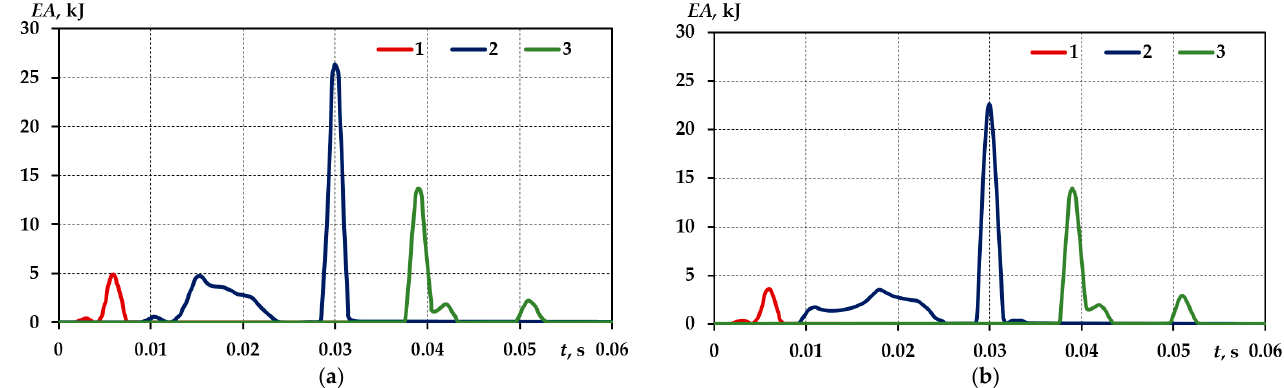
Figure 25. Time-dependent distribution of the energy amount absorbed by the zones: with the 2nd